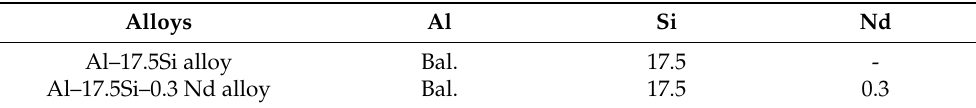
Table 1. The chemical components of alloy